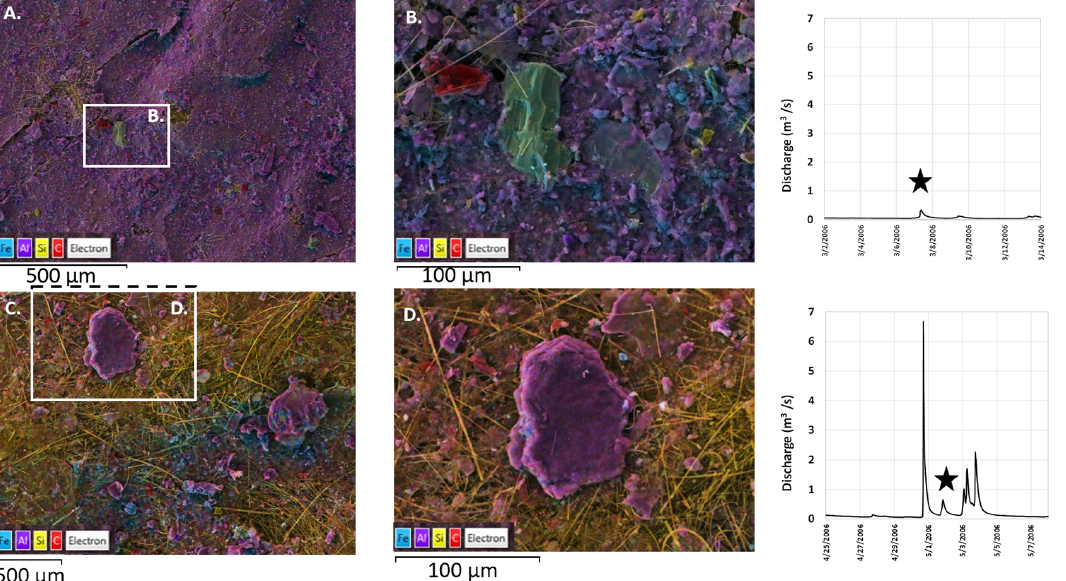
Figure 6. Representative SEM/EDS maps of selected Rio Mameyes filters under contrasted flow (as seen on the hydrographs on the right). ( A ) Low magnification composition map of overview area during low flow. ( B ) Composition map of area B in overview area A. ( C ) Low magnification image of filter collected during high flow. ( D ) Composition map of focus area D in overview area C. Si- rich fibers in the background are constituents of the filter membrane. Colors represent selected ele- ments (Fe, Al, Si and C). Stars on the hydrographs represent the time when the corresponding filter was collected.